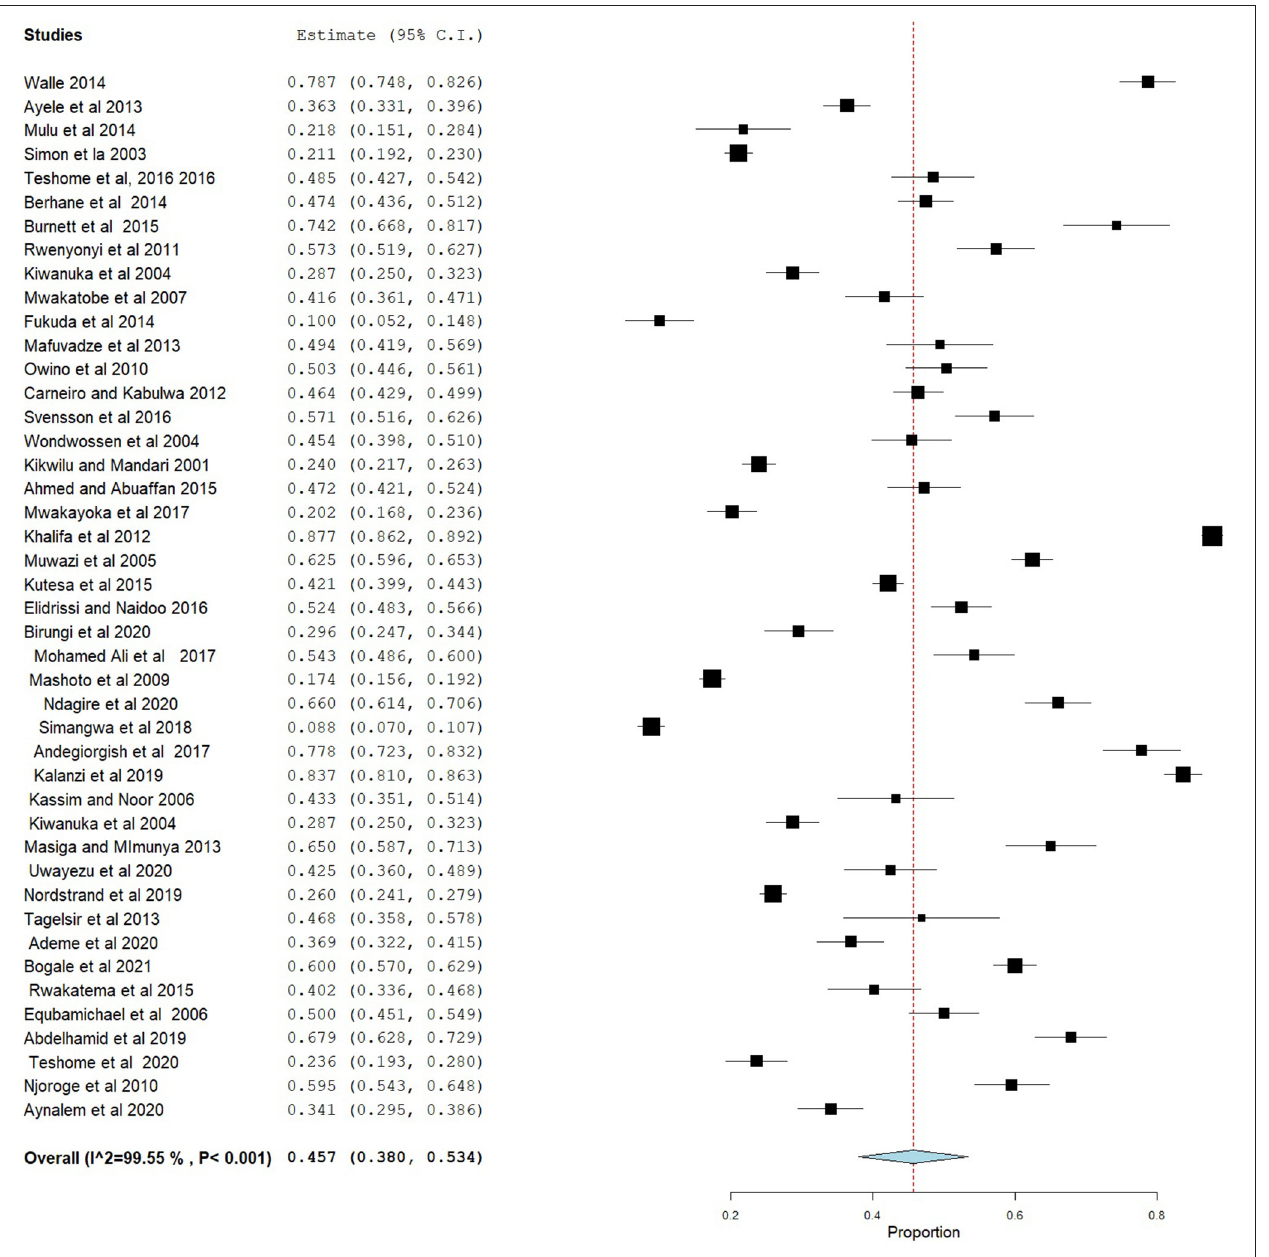
FIGURE 2 | Forest plot showing the pooled prevalence of dental caries in East